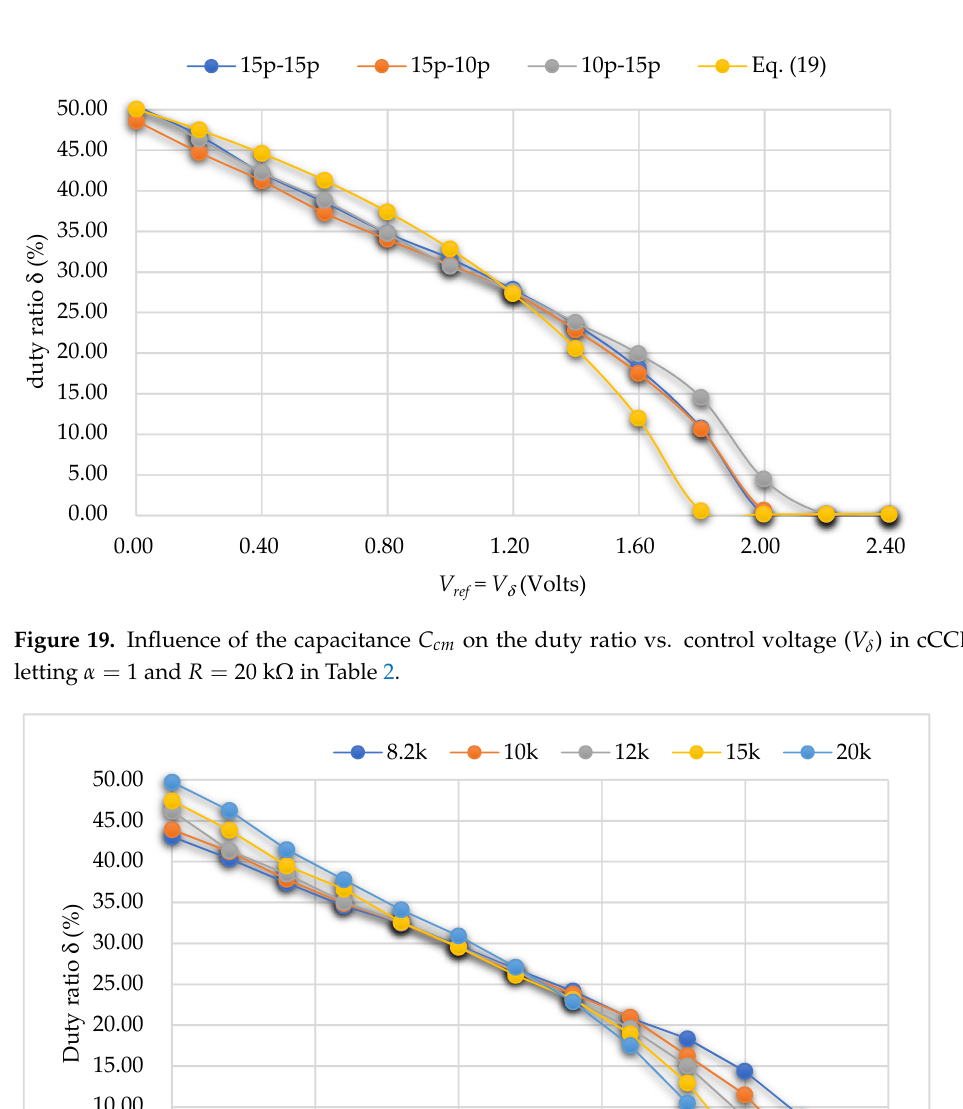
Figure 19. Influence of the capacitance 𝐶 (cid:3030)(cid:3040) on the duty ratio vs. control voltage ( 𝑉 (cid:3083) ) in cCCDA letting α = 1 and 𝑅 = 20 kΩ in Table 2.